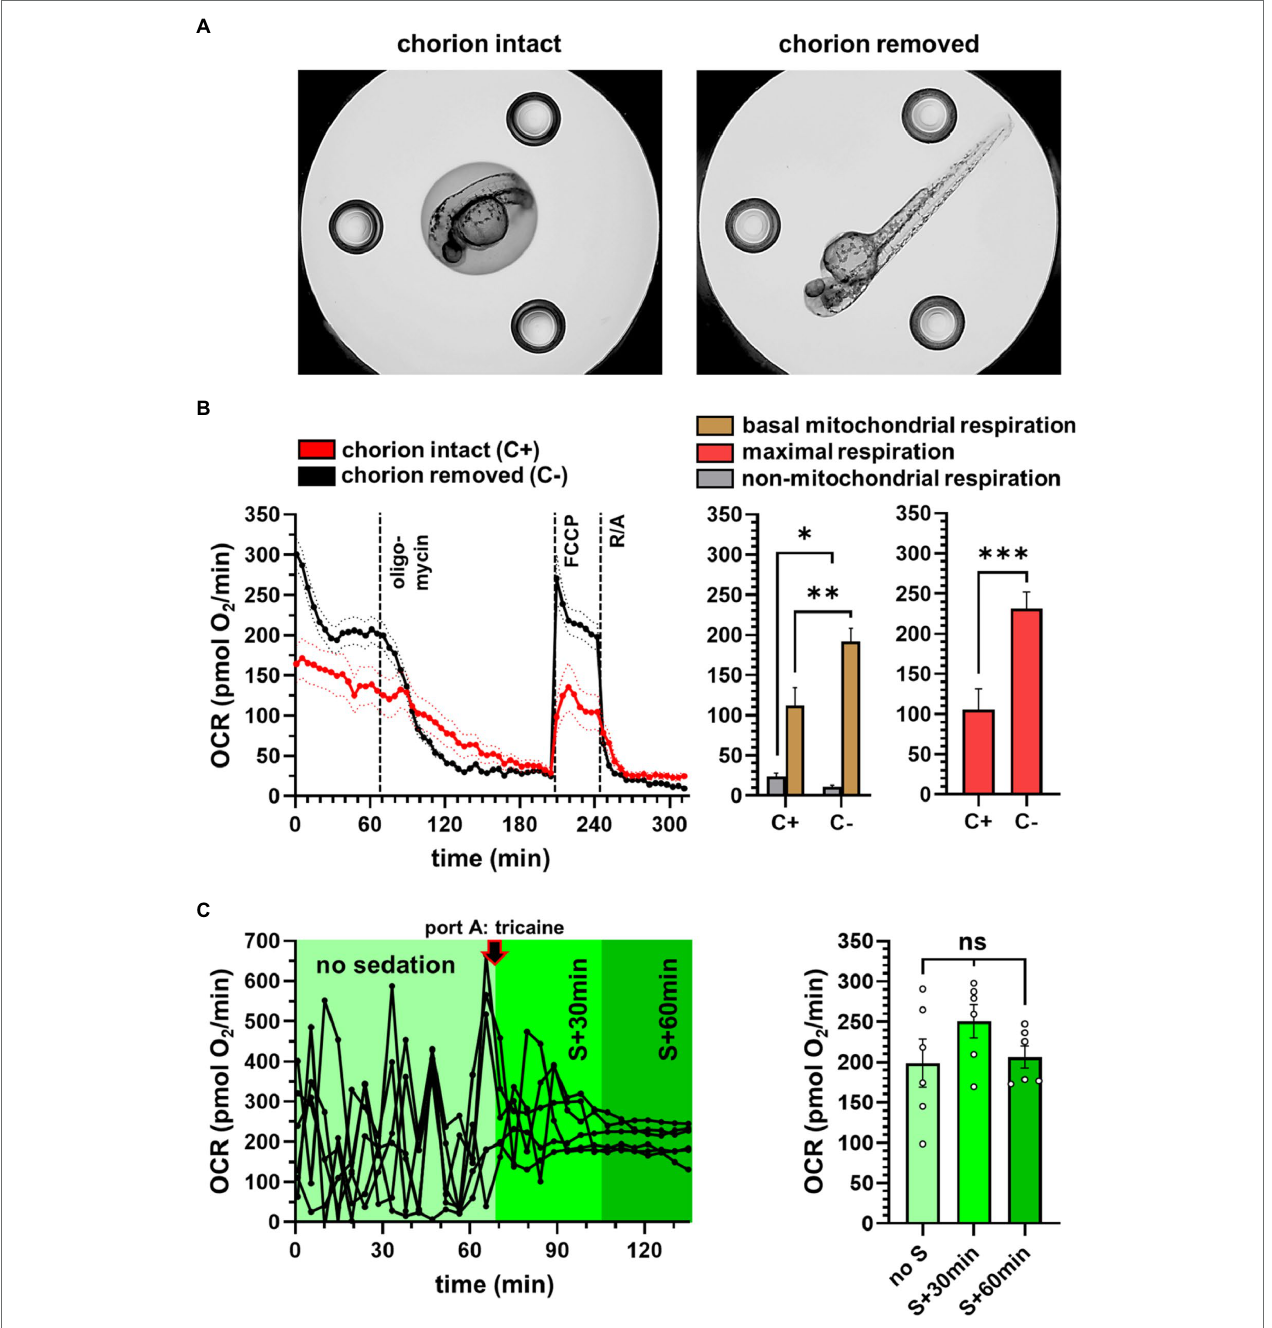
FIGURE 2 | Experimental conditions to measure zebrafish embryos in the XF96 Seahorse. (A) Microscopic image of the zebrafish embryos in the Seahorse well, without (left) and with (right) chorion removal. (B) Effect of the chorion on OCR, showing reduced OCR with an intact chorion. Mean traces represent 36 wells for each group. (C) Effect of sedation on the respiratory traces. Respiratory variability was evaluated on individual traces using six individual embryos. S: sedation. * p < 0.05; ** p < 0.005 ; *** p < 0.0005